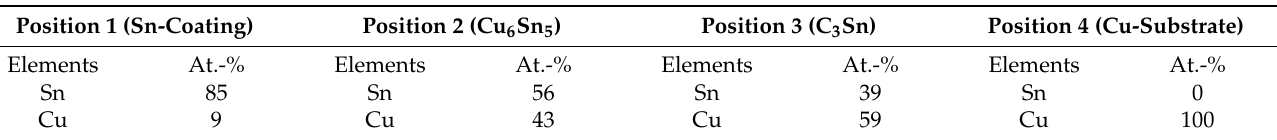
Figure 5. FIB investigations of an electrical connectors stressed by temperature cycles for 200 h and a maximum temperature of 140 °C: ( a ) Electron-beam stimulation (acceleration voltage: 5 kV, detection: SE); ( b ) Ion beam stimulation (acceleration voltage: 30 kV, detection: SE). Table 2. EDS analysis of chemical composition of the different layer after a temperature cycle test (acceleration voltage 10 kV).